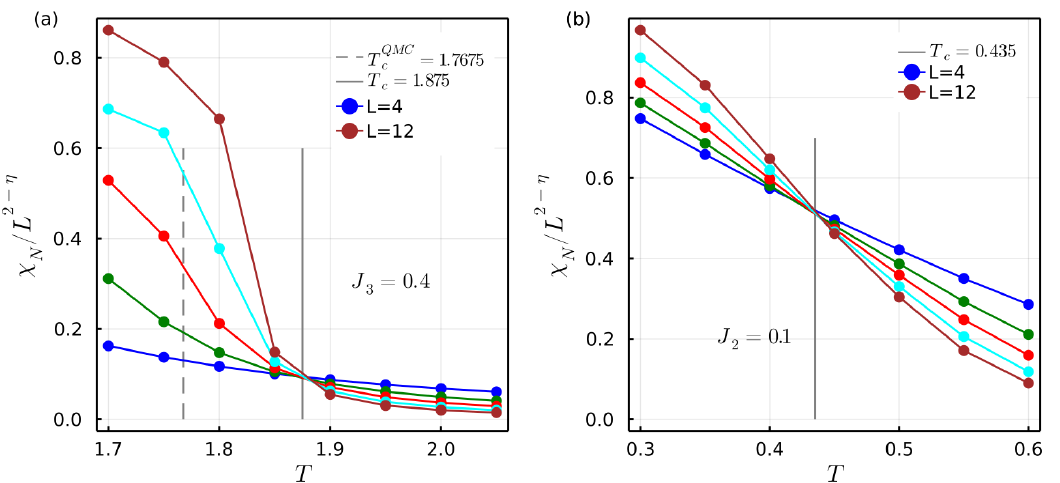
Figure 2: Scaling plot of the cubic lattice susceptibility similar to Fig. 1, but for the J = 0.4 (a) and the frustrated J J model with J 3 3 estimates for the critical temperatures follow from the unique crossing points of the data